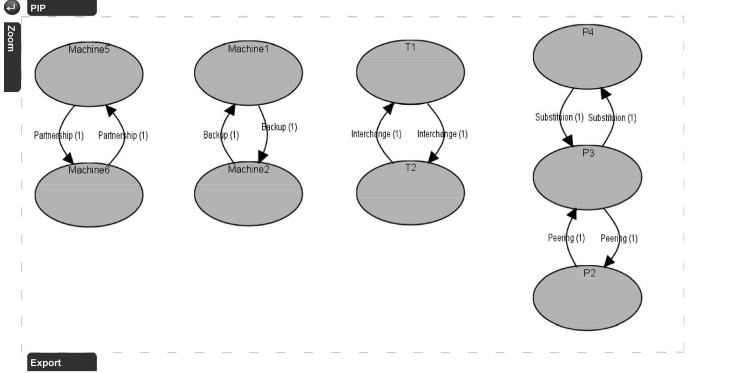
Figure 4. Screenshot of the BP execution social analysis component, a demo video is available at